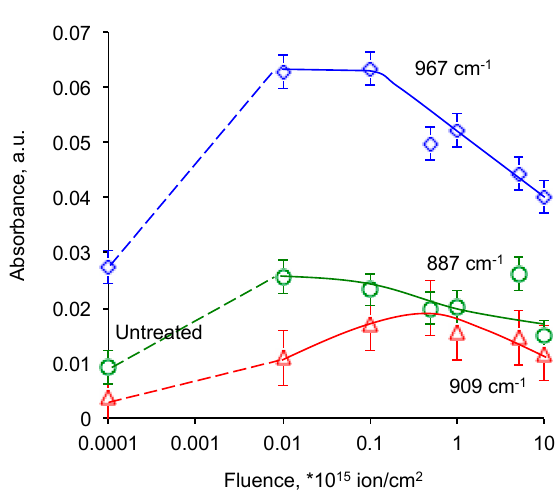
Figure 8. Normalized absorbance at 967 cm − 1 line of vinylene group, at 887 cm − 1 line of vinyliden group and at 909 cm − 1 line of vinyl group in FTIR ATR spectra of EPDM rubber with fluence of PIII.